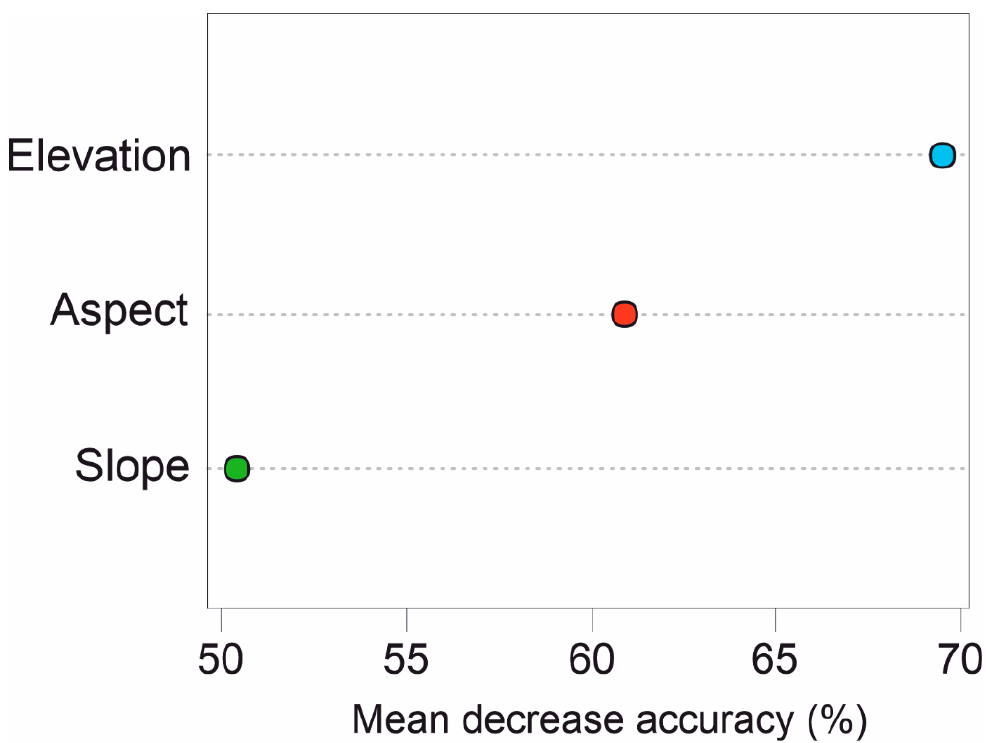
Figure 3. Relative importance of site predictors for classifying the 89 relevés in the eight clusters (plant associations) distinguished on the dendrogram (see Figure 2).